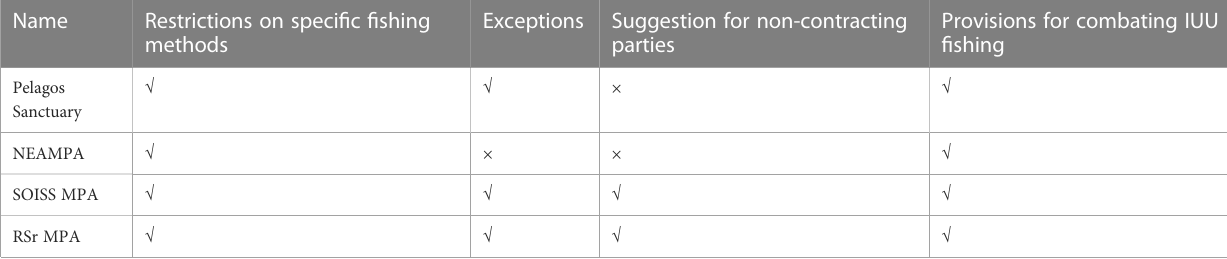
TABLE 2 Reasonable fi shing-restriction measures in the four high seas MPAs (Simpli fi